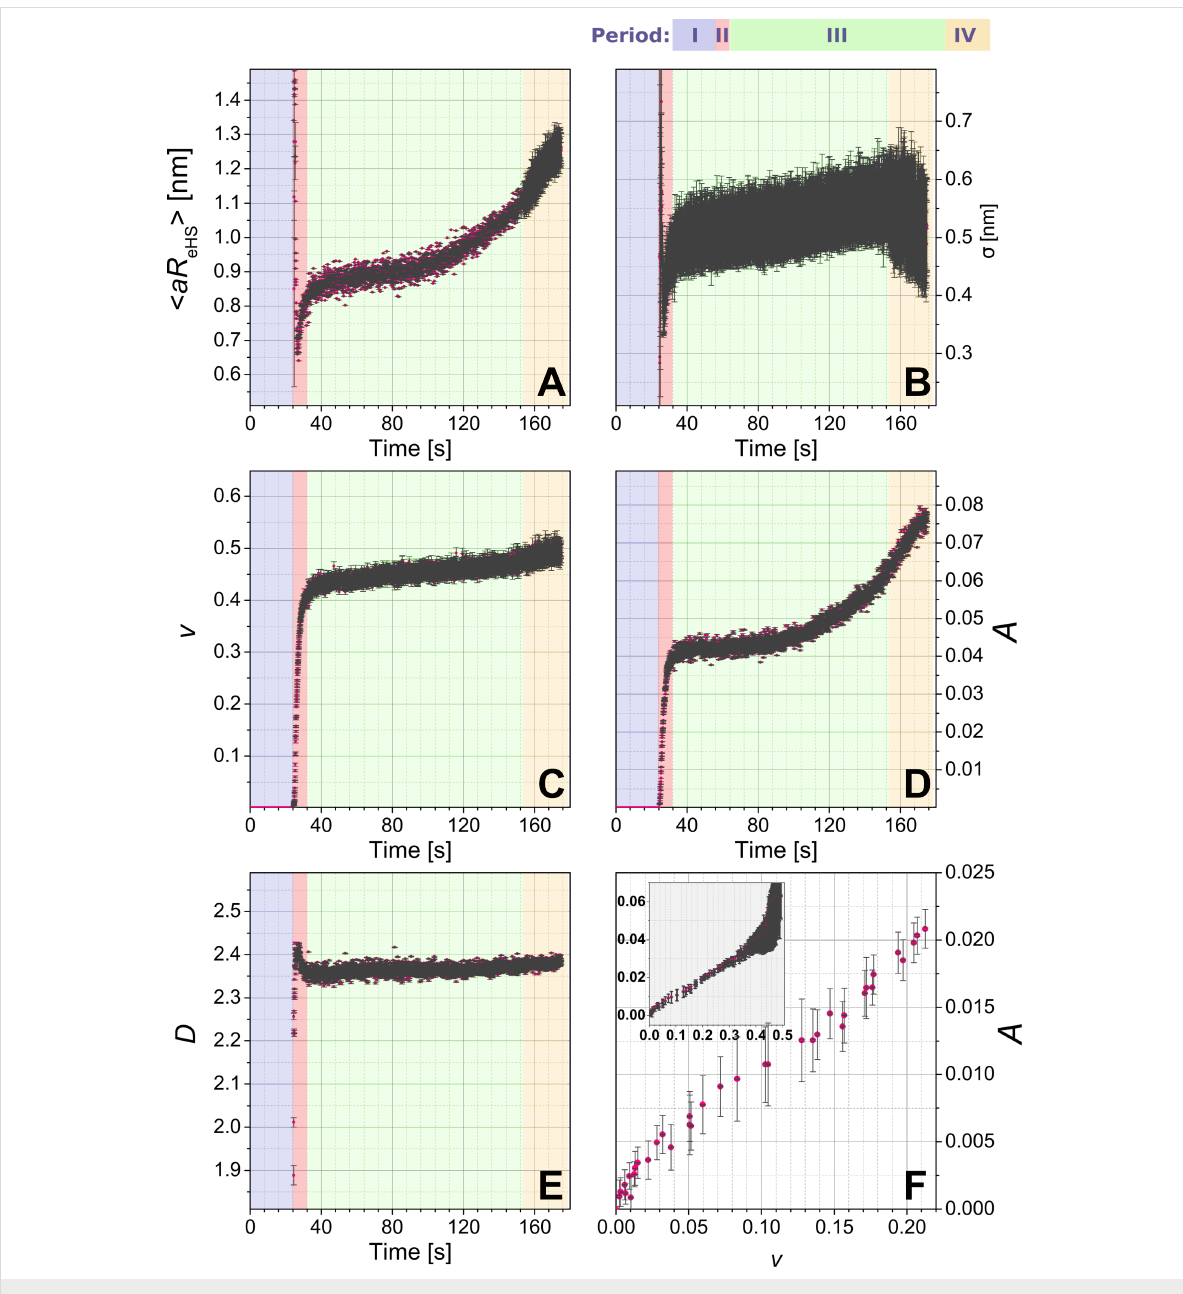
Figure 4: Evolution in the crucial parameters of the fitting model plotted as a function of the time. A) Mean additional hard sphere radius < aR eHS >; B) the corresponding standard deviation σ ; C) local volume fraction ν ; parameters characterising < S agg ( q )>: D) A , relative product of the number density of the aggregates N agg and their specific surface area SAA agg ; E) dimensionality of the aggregate D ; F) correlation A vs ν , with inset showing the same as the main Figure 4F, but for a wider range; axes legends in the inset correspond to those in the main